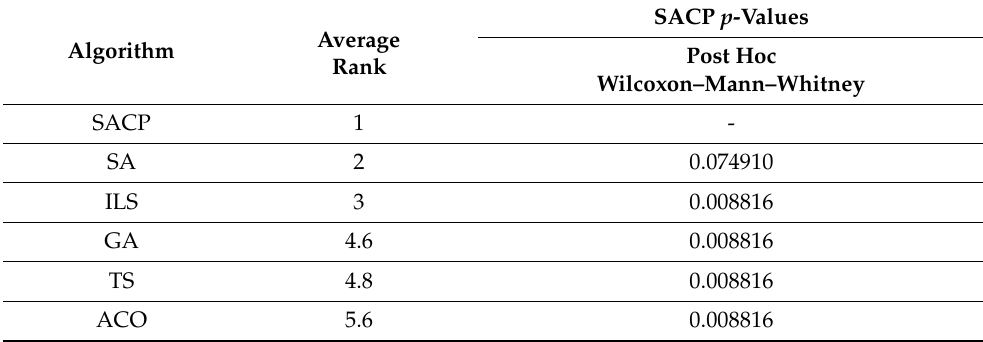
Table 7. Post hoc test and average ranking for multiple p -values comparisons between SACP vs. other algorithms taken only data from medium